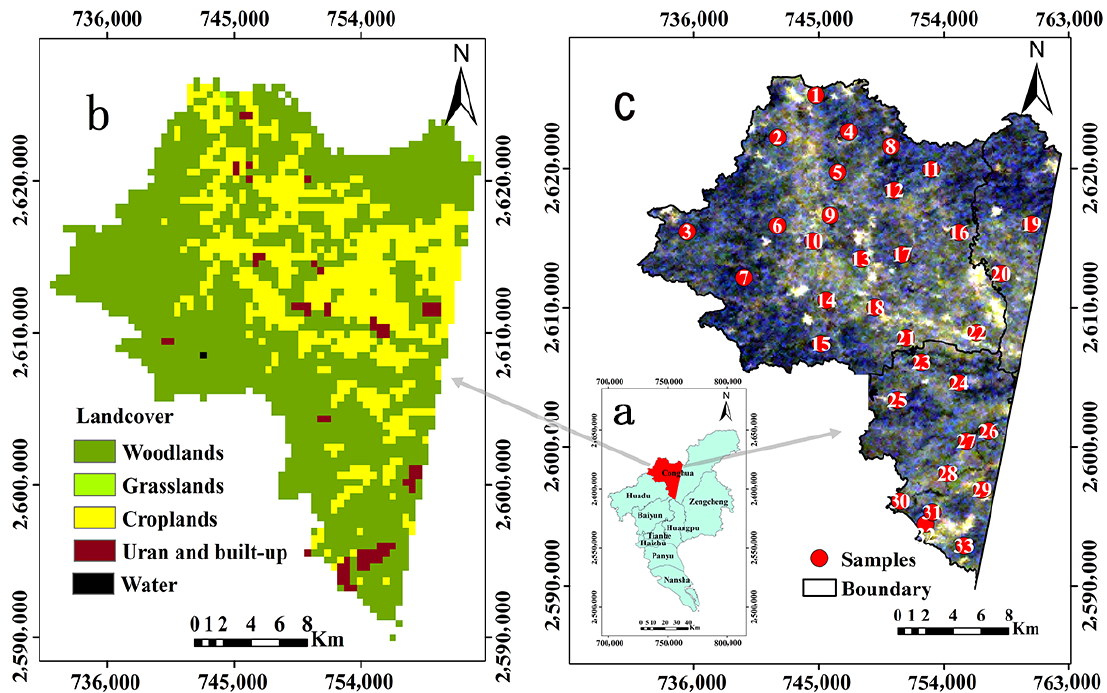
Figure 2. ( a ) The location of the test study area in Guangzhou city (red area shown in Figure 1a); ( b ) the land cover map of the study area used for testing the optimal hyperspectral estimation models; and ( c ) the test study area shown using a false color composite image from HuanJing-1A data, with the spatial distributions of 33 soil samples used for assessing the accuracy of estimated soil heavy metal